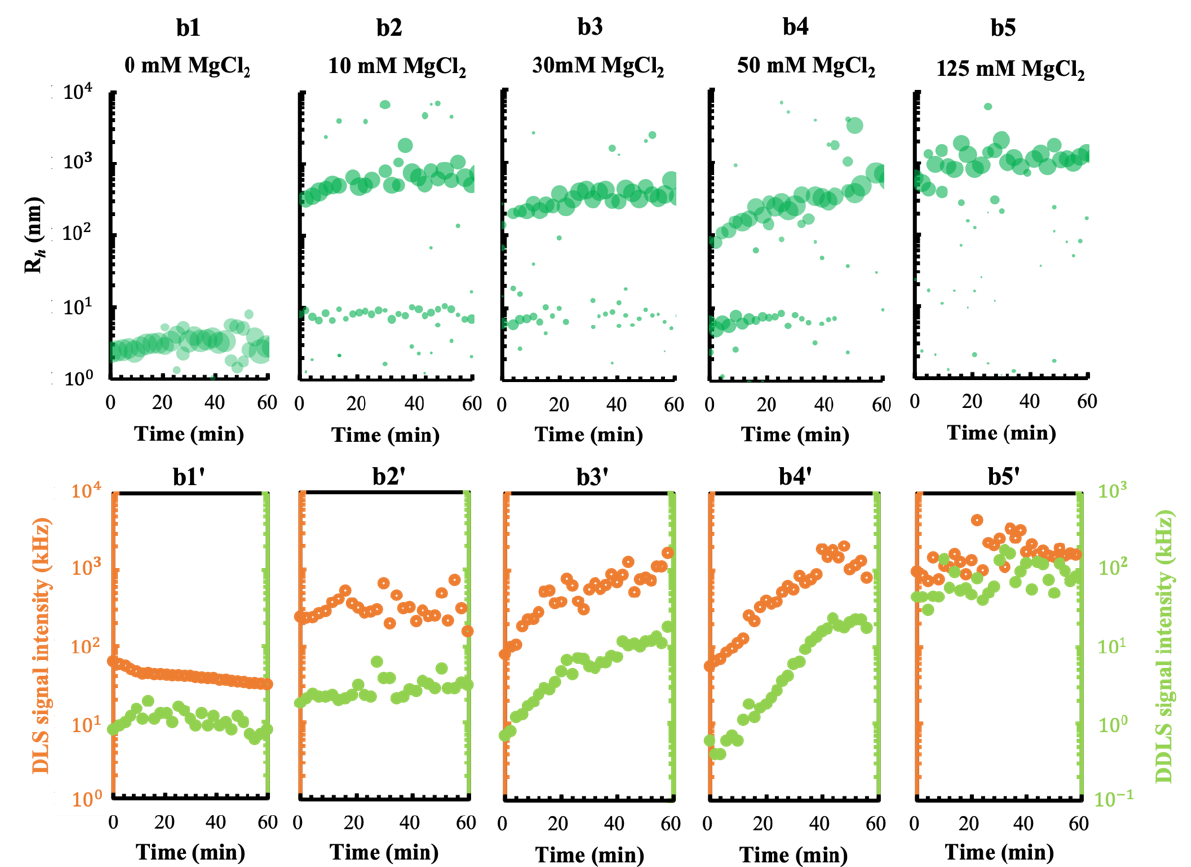
Figure 4. Monitoring phase transition of a 2 mg/mL GI solution by DLS and DDLS under the effect of Na + and Mg 2+ gradients in 10 mM MES pH 6.5 and 4% PEG20k buffer. ( a1 – a5 ) Kinetic evolution of the hydrodynamic radius in the presence of a NaCl gradient ( a1 ′ – a5 ′ ) showing the resultant DLS (left Y-axis, orange open circles) and DDLS (right Y-axis, green closed circles) signal intensities. ( b1 – b5 ) Kinetic evolution of the hydrodynamic radius and ( b1 ′ – b5 ′ ) corresponding DLS/DDLS signal intensities of a GI solution by mixing the solution with a MgCl 2 gradient.